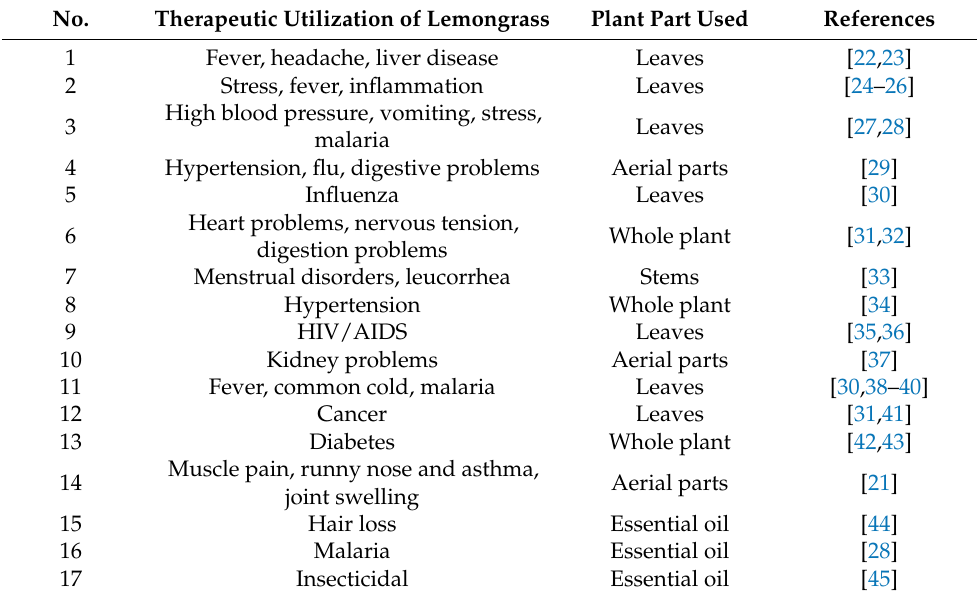
Table 2. Therapeutic utilization of lemongrass. No. Therapeutic Utilization of Lemongrass